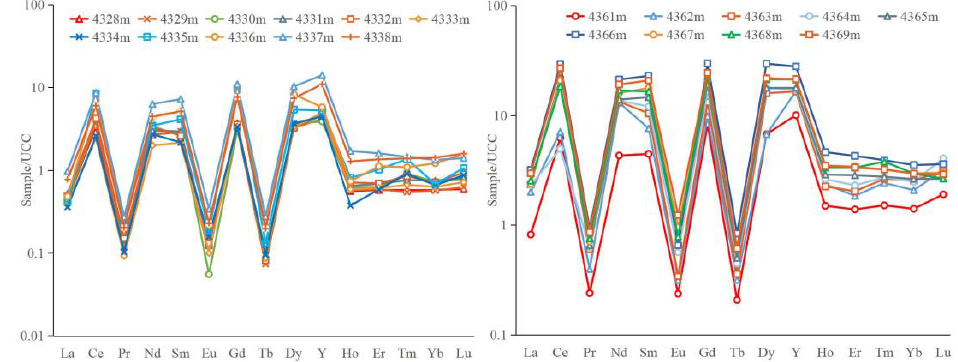
Figure 3. The standardized distribution pattern of rare earth elements in the Wujiaping Formation’s shale samples.